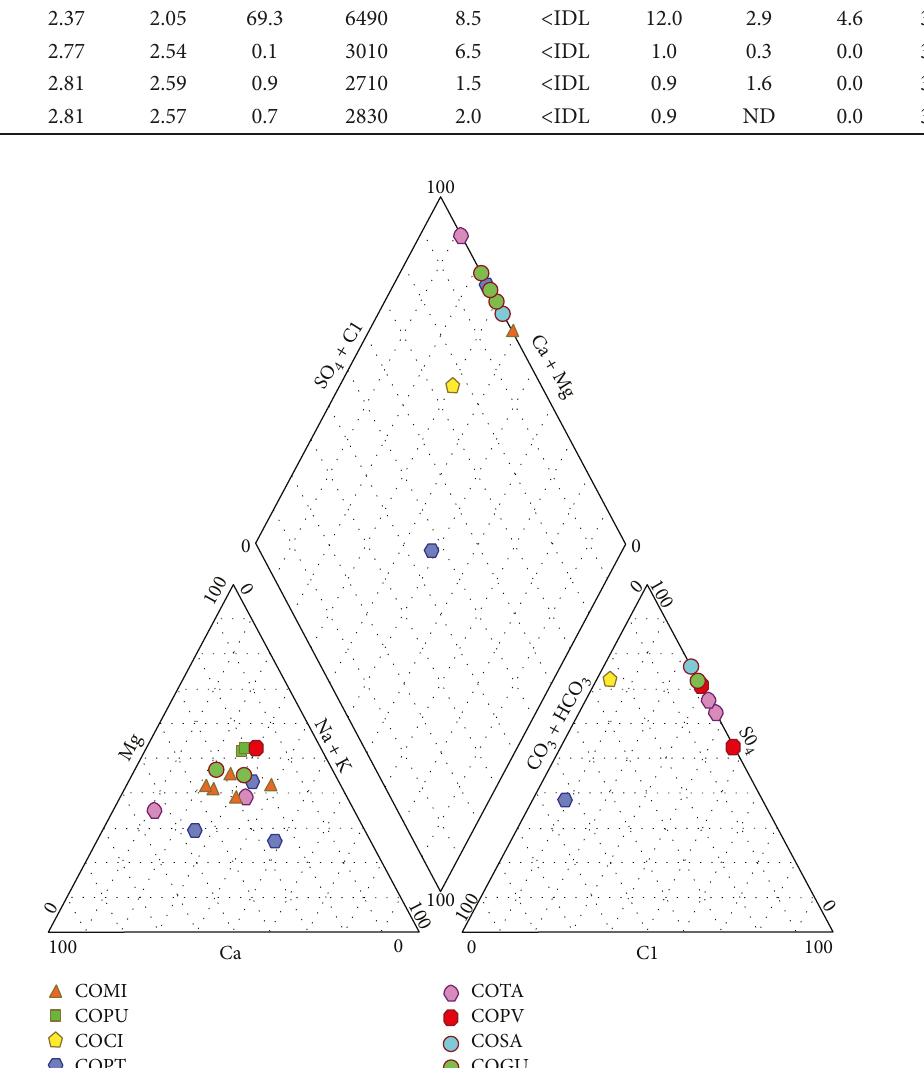
Figure 4: Piper diagram showing the hydrochemical compositions of some hot springs in the Puracé-La Mina sector.